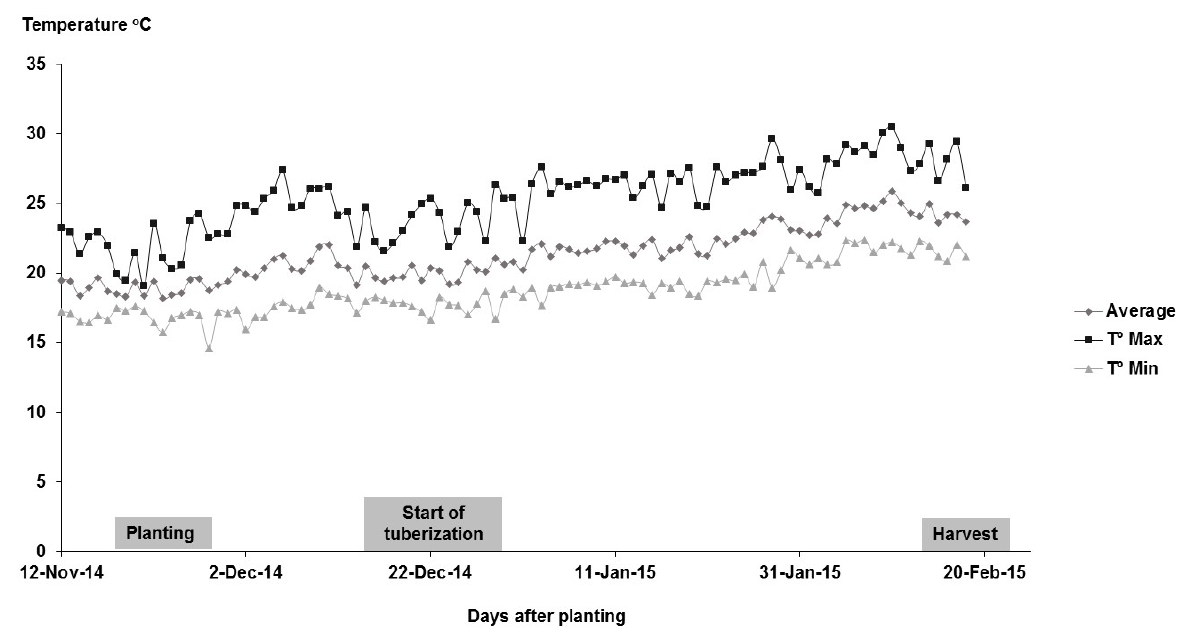
Figure 3: Temperatures during growing season in La Molina, Peru, November 2014 to February 2015